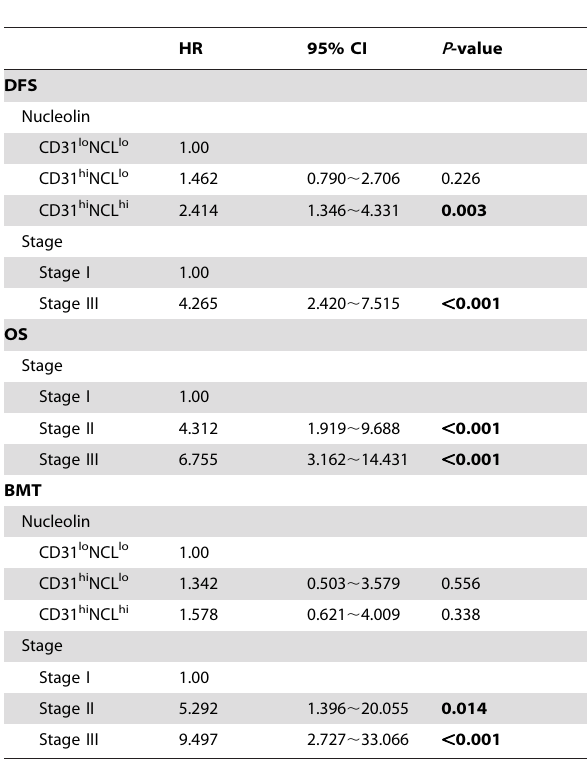
Table 3. Multivariate Cox’s proportional hazards model analyses of survival and bone metastasis